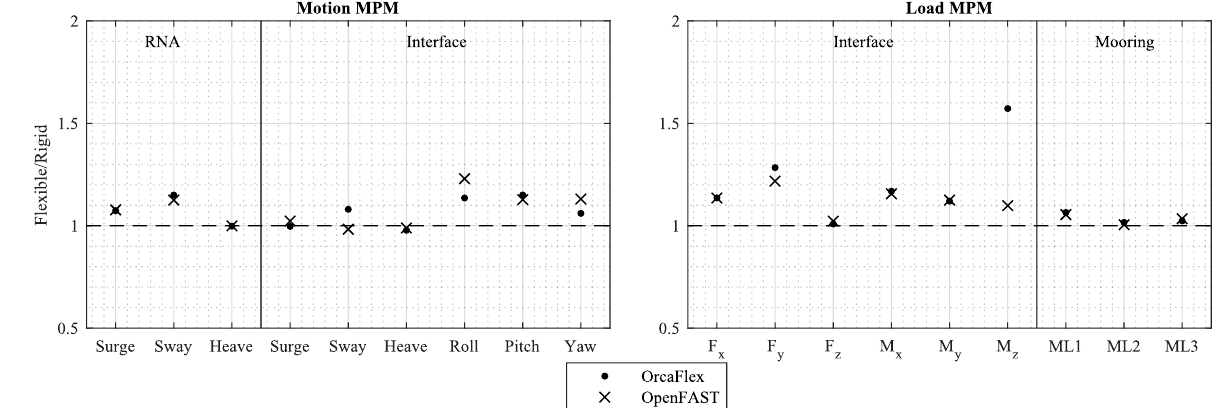
Figure 11. Comparison of MPM-values for motion and loads at the RNA and interface. ( Left ) Motion response. ( Right ) Load response.